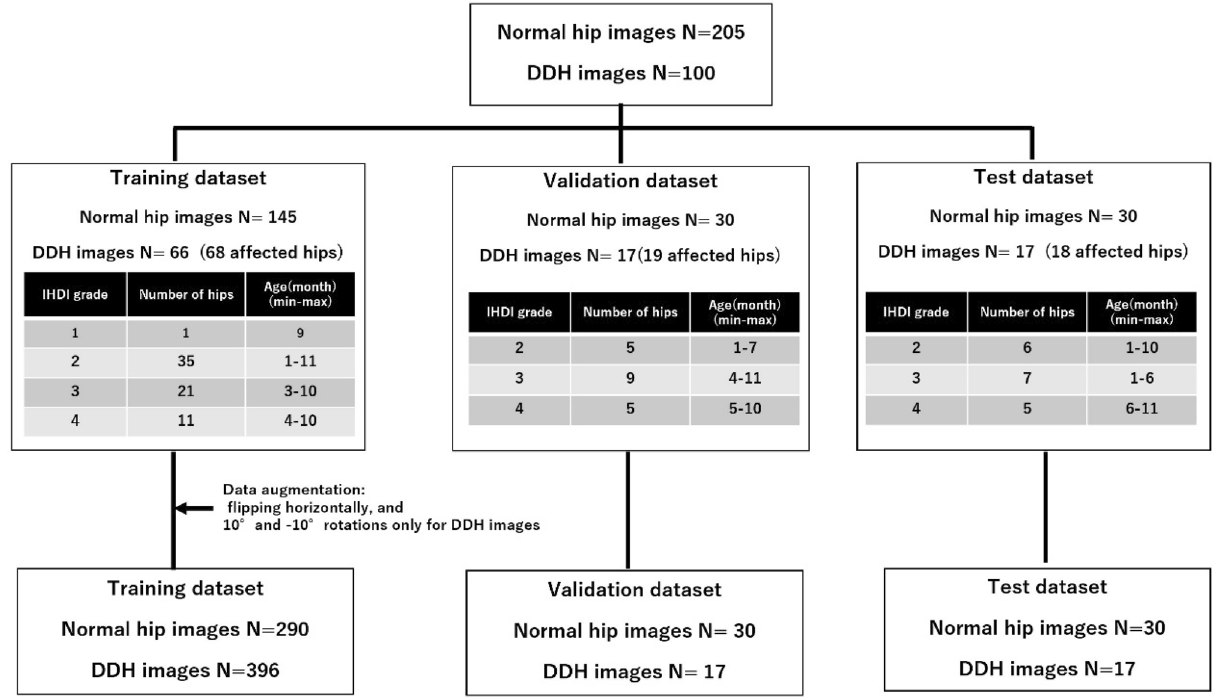
Figure 4. Flowchart of data preparation. DDH: developmental dysplasia of the hip.